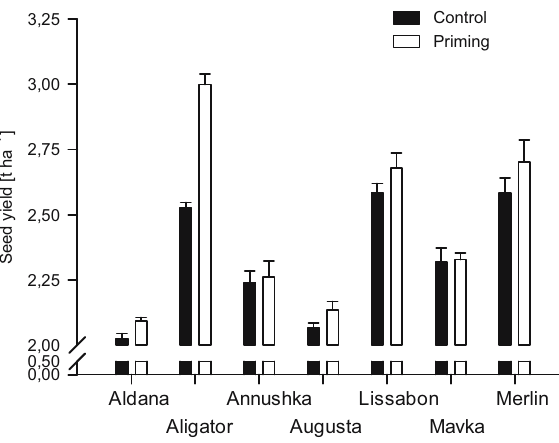
Figure 1: E ff ect of seed priming and soybean variety on seed yield ( mean + standard error; treatment: P < 0.0001; variety: P < 0.0001; interactions T × V : P < 0.0001 )